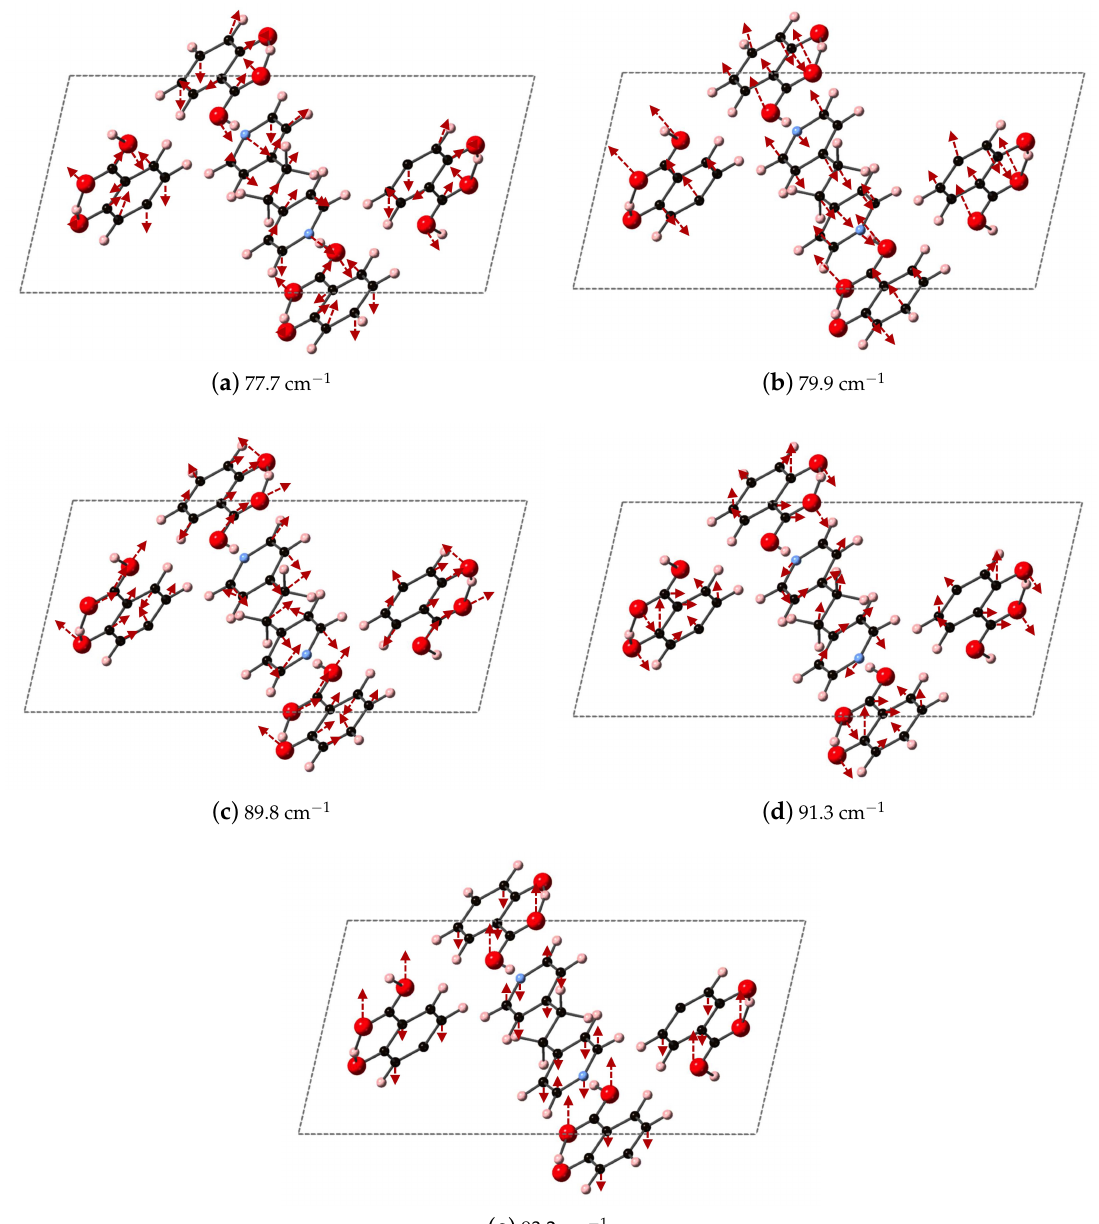
Figure 11. Shown here are the DFT-D computed IR active modes of 2(SA) · BPEth that occur at ( a ) 77.7 cm − 1 (along xz ); ( b ) 79.9 cm − 1 (along y ); ( c ) 89.8 cm − 1 (along xz ); ( d ) 91.3 cm − 1 (along y ); and ( e ) 93.2 cm − 1 (along xz